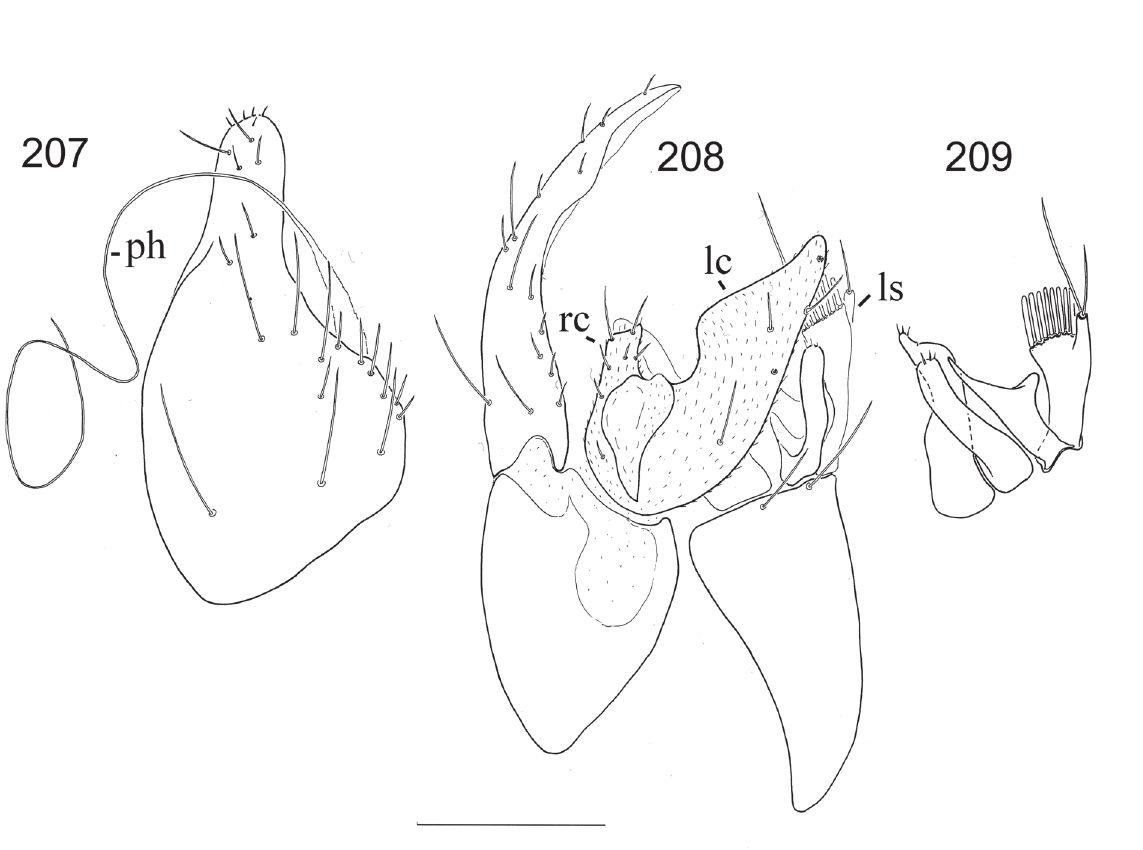
Figs 207-209. Stilpon goesi Shamshev & Grootaert, 2006, ♂ terminalia. 207 . right surstylus, lateral view. 208 . epandrium with cerci, dorsal view. 209 . left surstylus, lateral view. Scale bar= 0.1 mm (after Shamshev & Grootaert